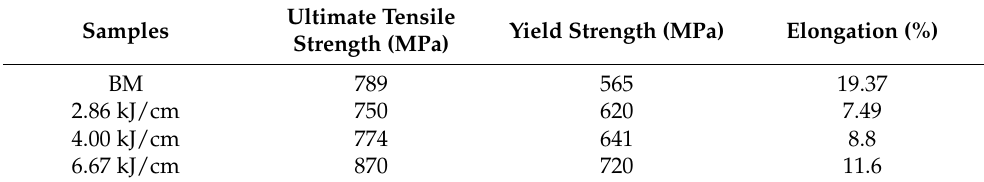
Figure 9. The microhardness of the welded joints with different heat inputs.